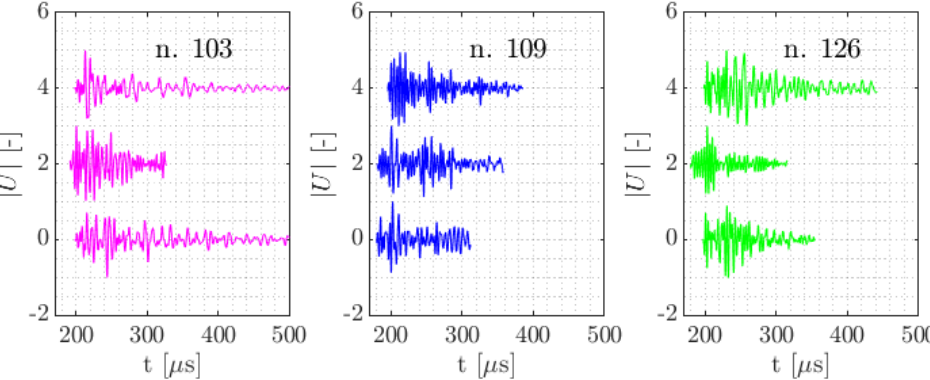
Figure 16. Normalised examples of waveforms from cluster numbers 103, 109 and 126.